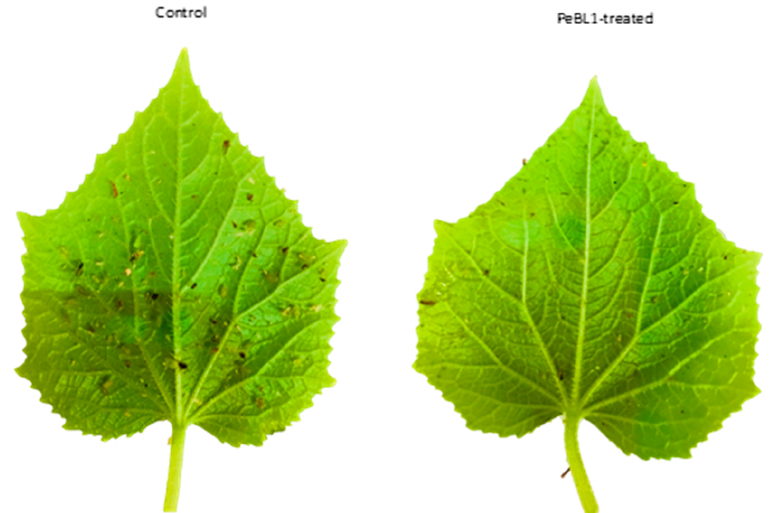
Figure 5. Myzus persicae that fed on PeBL1 showed a reduction in the number of offspring as compared to the control plants. to the control